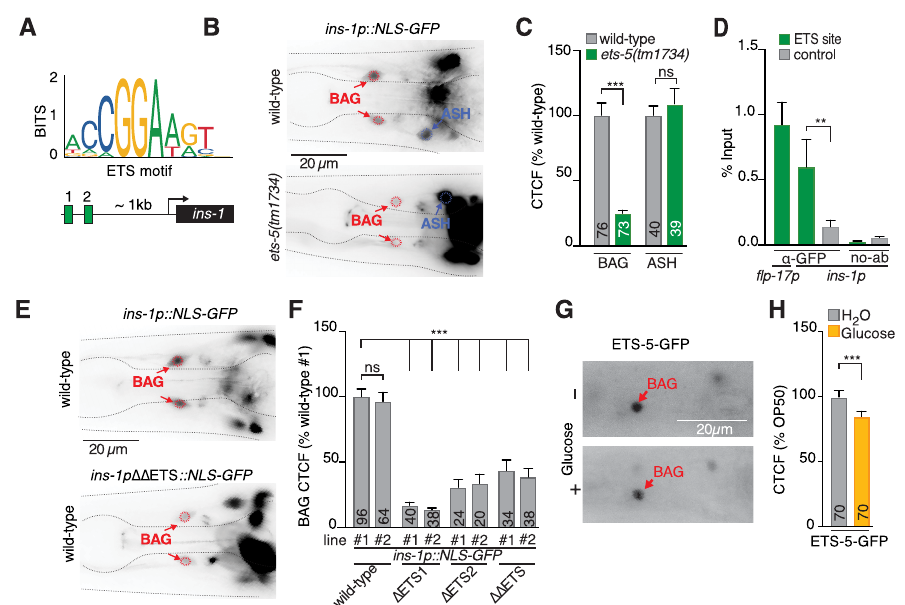
Fig 3. The BAG-specifying transcription factor ETS-5 regulates ins-1 expression. (A) The ins-1 promoter contains two adjacent ETS motifs (green boxes). (B) Representative images of ins-1p :: NLS-GFP expression in ets-5(tm1734) animals compared to wild-type. Red circles: BAG neurons, blue circle: ASH neurons. Scale bar 20 μ m. (C) Quantification of GFP intensity (CTCF) of ins-1p :: NLS-GFP in the BAG and ASH neurons in wild-type and ets-5 (tm1734) animals. Data presented as � x + SEM, n shown within bar. Significance assessed by unpaired t test. (D) ETS- 5-GFP ChIP-qPCR. Regions assessed: flp-17 promoter and ins-1 promoter containing ETS-sites (green), ins-1 promoter non-ETS-5 site region (gray), and no-antibody control (no-ab). Data are presented as � x +SEM, n = 4. Significance assessed by ratio paired t test. (E) Representative images of ins-1p :: NLS-GFP with both putative ETS sites mutated ( ΔΔ ETS) compared to wild-type. Red circles: BAG neurons. Scale bar 20 μ m. (F) Quantification of GFP intensity (CTCF) in BAG relative to wild-type control line #1, with ins-1 promoter mutated at ETS1, ETS2, or both, 2 independent lines assayed, n shown in bar. Significance assessed by 1-way ANOVA with Dunnet’s correction. (G) Representative images of endogenous ETS-5-GFP expression in the BAG neurons (red arrow) of animals fed standard diet ( E . coli OP50) (upper panel) and high glucose diet ( E . coli OP50 + 40 mM glucose) (lower panel). Diet treatment: 24 hours. Scale bar 20 μ m. (H) Quantification of endogenous ETS-5-GFP expression in the BAG neurons of animals fed standard diet ( E . coli OP50, gray bar) and high glucose diet ( E . coli OP50 + 40 mM glucose, yellow bar), displayed as CTCF values as % of OP50 value. Diet treatment: 24 hours. Data presented as � x + SEM, n shown in bar. Significance assessed by unpaired t test. For all data: ns, not significant ( p > 0.05), � = p � 0.05, �� = p � 0.01, ��� = p � 0.001. The underlying numerical data can be found in S1 Data. CTCF, calculated total fluorescence; GFP, green fluorescent protein; RNA